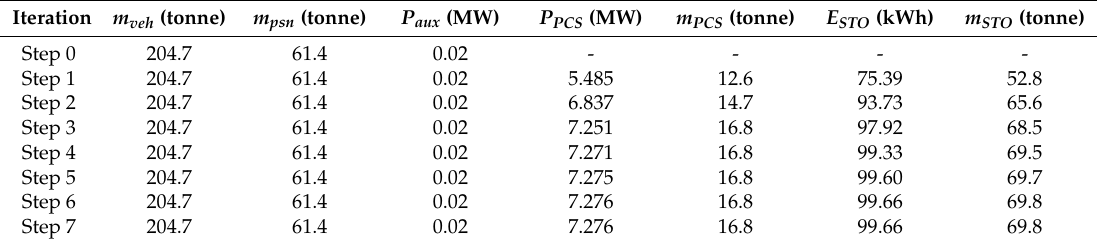
Figure 7. Final electrical power characteristics, remaining energy, and modified load characteristics for the up- and down-line driving train at final iteration step. ( a ) up-line train; ( b ) down-line train. Table 2. Results of each iteration step for power and storage capacity optimization ( m uESP = 0.7 tonne/kWh, m uPCS = 2.1 tonne).